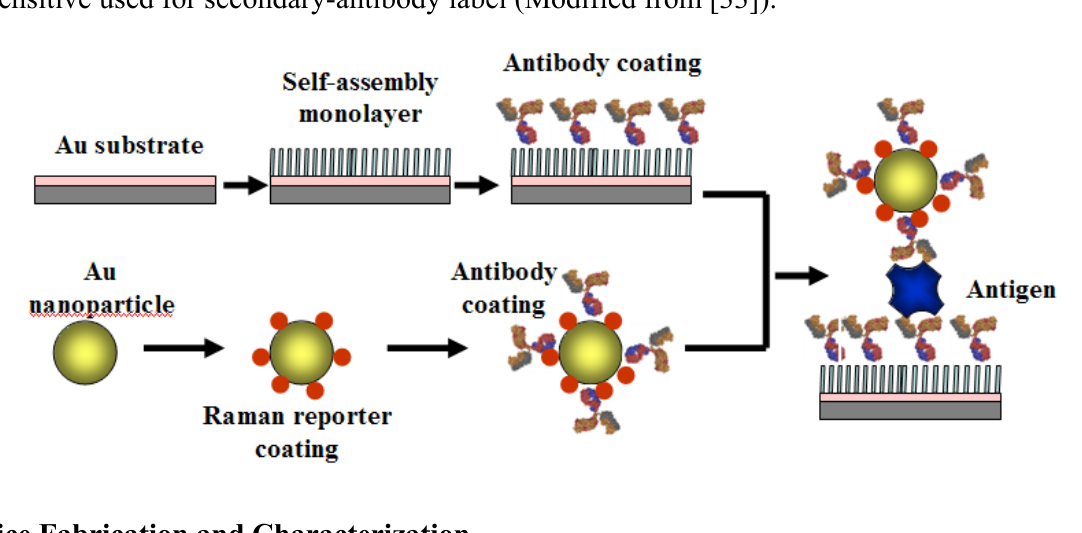
Figure 4. SERS-based immunosensor platform; a gold nanoparticle is coated with Raman- sensitive used for secondary-antibody label (Modified from